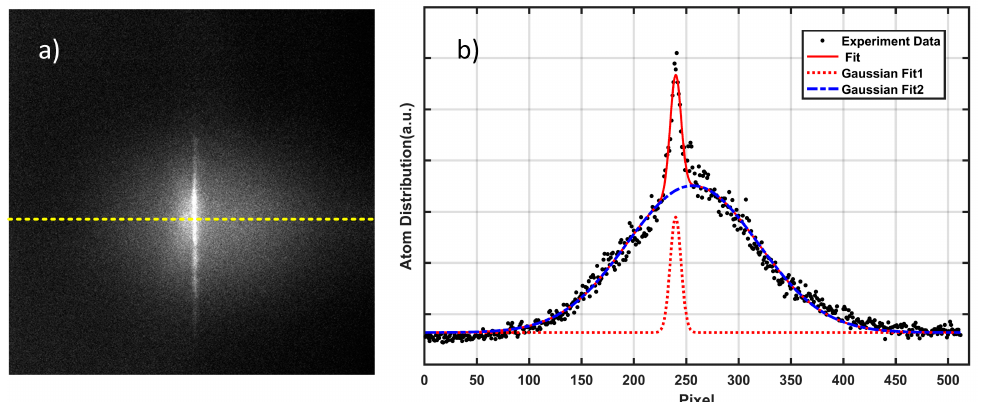
Figure 4. ( a ) Images of guided atoms released after 20 ms in the dipole trap. ( b ) Atom distribution indicated by the horizontal yellow dashed line in ( a ) over 512 pixels. The profile (red solid line) is fitted by two added Gaussian functions, where Fit1 (red dashed line) and Fit2 (blue dash dotted line) represent the guided and unguided atoms, respectively.